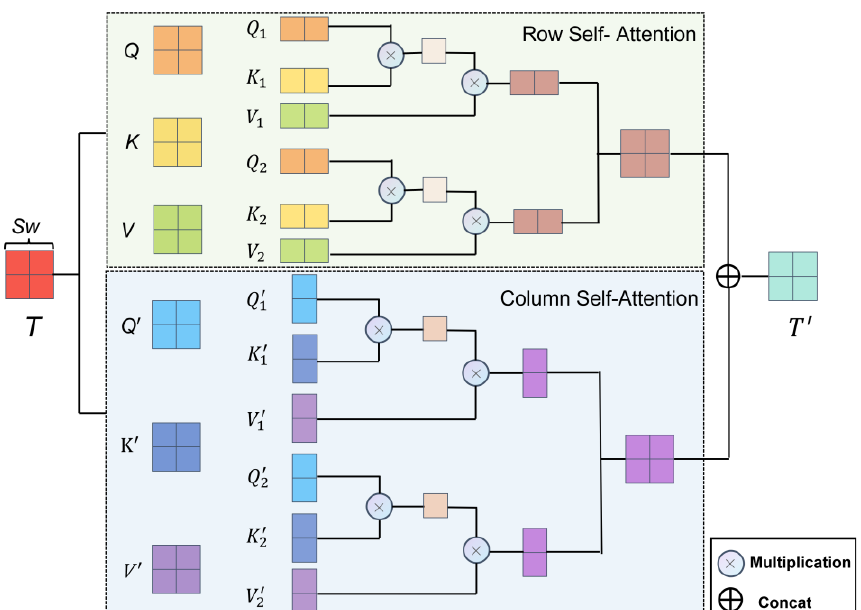
Figure 2. Architecture of the stage1. We use two parts to calculate the global attention of the feature graph T in stage 1; one part calculates the row attention and one part calculates the column attention. Finally, these two parts are combined to achieve parallel processing of the output feature map T’. Similarly, stage 2, stage 3 and stage 4 also output the corresponding attentional feature maps.